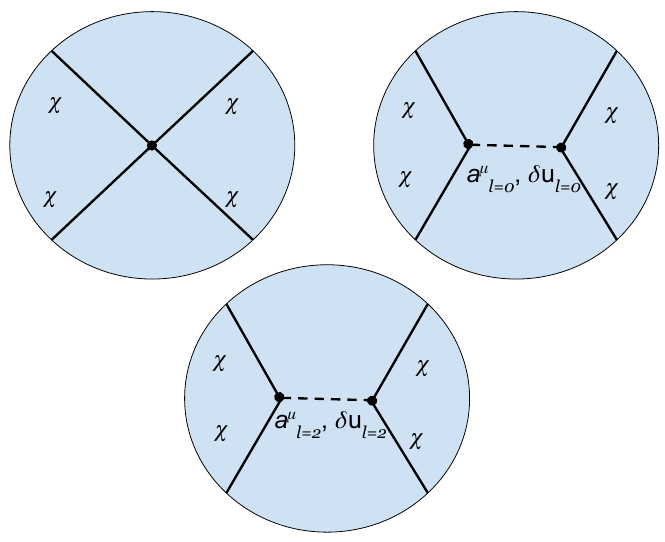
Figure 19. Witten diagrams for computing the connected part of the four-point function h χ i χ i χ i χ i i . Both l = 0 and l = 2 modes of δu and a µ fields are exchanged in the exchange 1 2 3 4